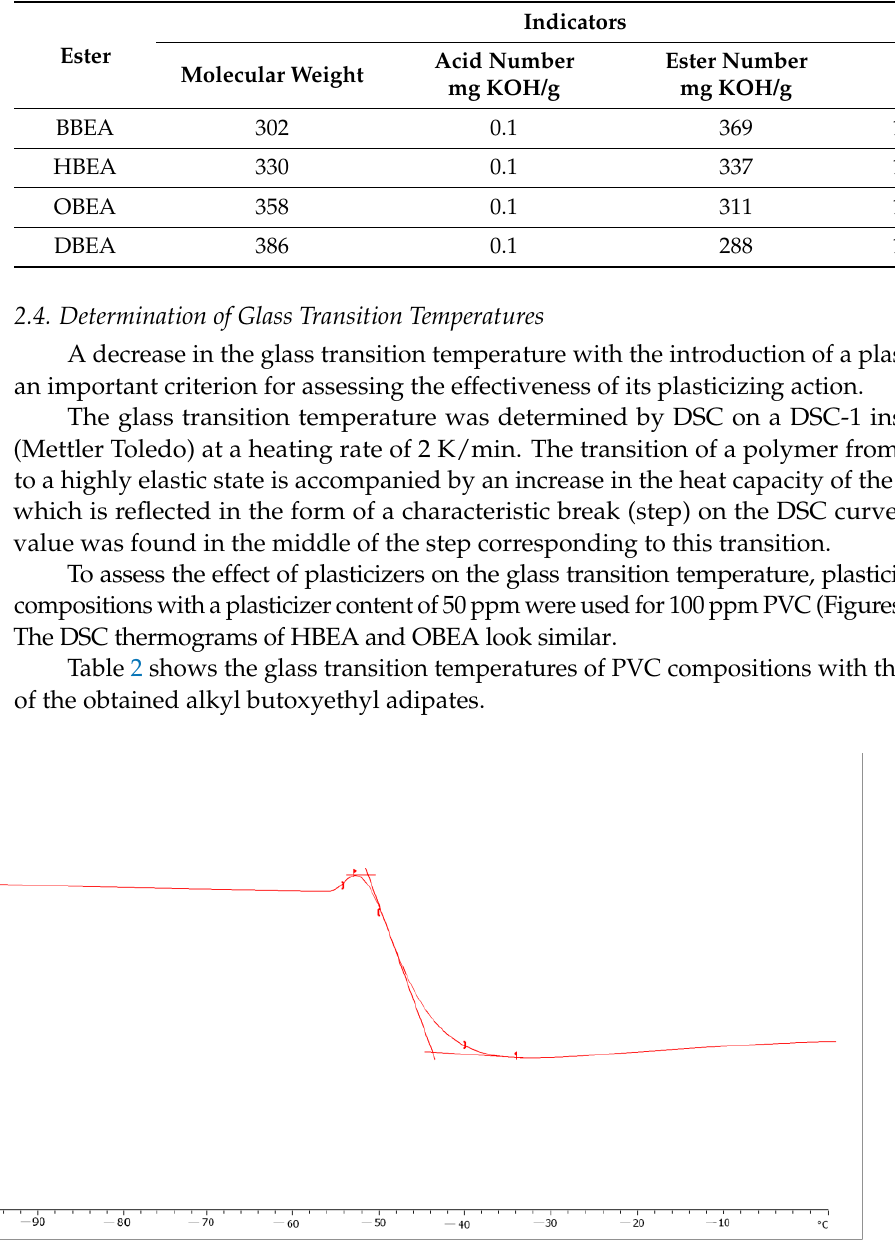
Table 1. Physicochemical properties of alkyl butoxyethyl adipates. Ester Molecular Weight